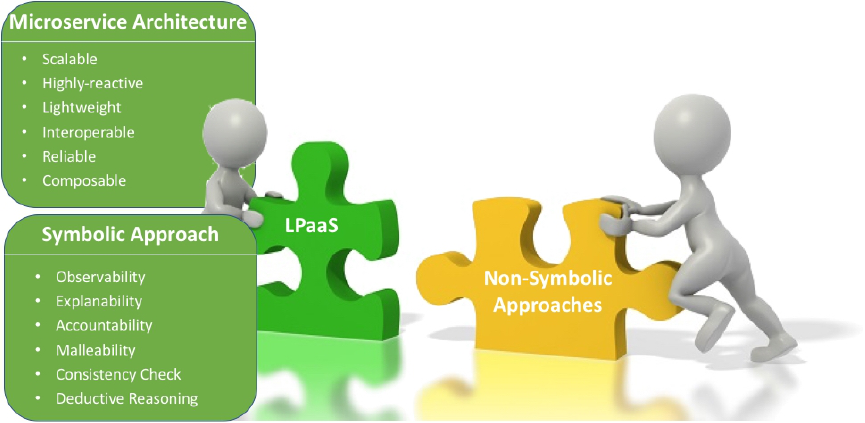
Figure 1. Logic Programming as a Service (LPaaS) contribution with respect to (i) Internet of Things (IoT) software engineering (SE) challenges and (ii) complementing non-symbolic